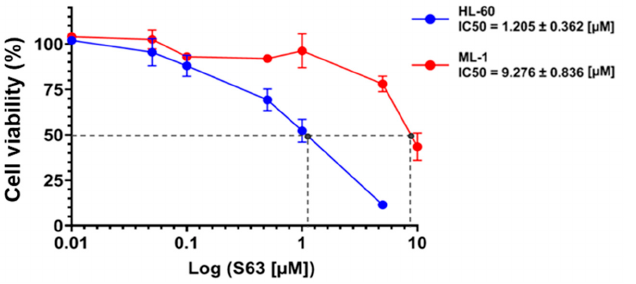
Figure 1. Dose–response curves of AML cell lines treated with MCL-1 inhibitor S63845 (S63) for 48 h. Analysis of HL-60 and ML-1 cell viability was performed using PrestoBlue assay. Based on the obtained data of three independent experiments performed in triplicate, the IC50 values for both AML cell lines were calculated. Next, in order to examine the combined e ff ects of S63845 and ABT-737 on AML cell viability, the concentrations of S63845 and ABT-737 below the IC50 values for each leuke- mic cell line were used. The concentrations of ABT-737 were chosen based on our previous studies, where we showed that ML-1 cells are more resistant to this BCL-2 inhibitor than HL-60 cells [27]. The exposure of both HL-60 and ML-1 cells to S63845 in combination with ABT-737 resulted in a decrease in cell viability to a higher degree than did each of the tested agents alone (Figure 2A,B, respectively). Importantly, although all combina- tions of the two inhibitors used to treat HL-60 cells signi fi cantly reduced their viability in comparison with the corresponding single-agent treatments, a decrease in HL-60 cell via- bility below 50% was observed only when S63845 and ABT-737 were used in the highest concentration of 0.1 µM and 5 µM, respectively (Figure 2A). In the case of ML-1 cells, all combinations applied caused a decrease in cell viability below 50% (Figure 2B). To con fi rm that the interactions between the tested agents were synergistic in HL-60 and ML-1 cells, the combination index values were calculated. In both leukemia cell lines, the CI values were below 1, indicating synergism. The CI values in HL-60 cells ranged from 0.35 to 0.65 and from 0.08 to 0.42 in ML-1 cells (Figure 2A,B, Supplementary Figure S1).